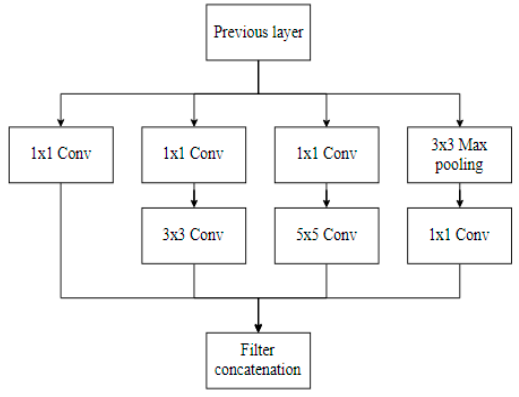
Figure 6. The inception module.